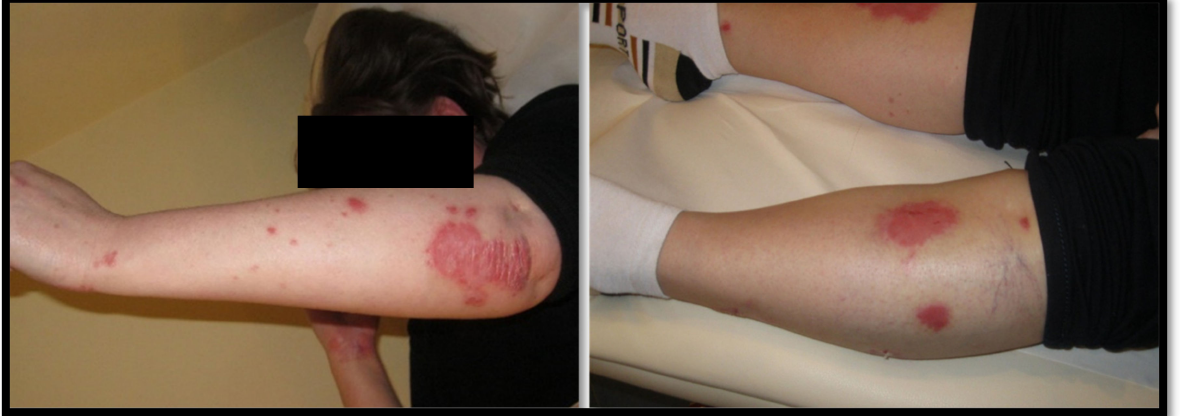
Figure 2. The skin condition of a patient with psoriasis after 10 days of radiation in the hospital. Source: materials provided by one of the experts (with the consent of the